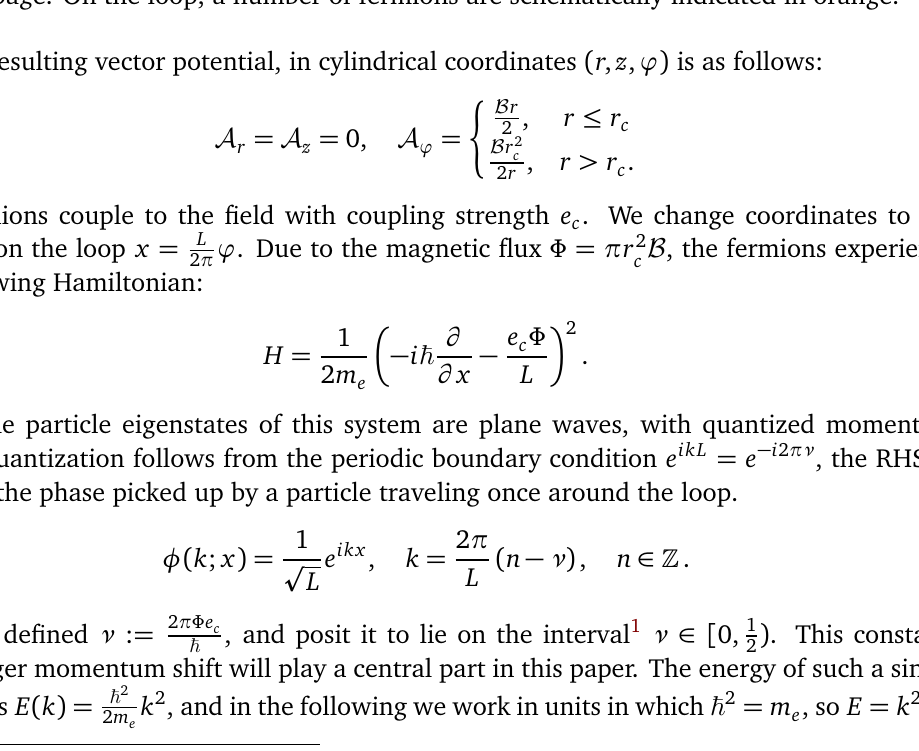
Figure 1: Setup for the Aharonov-Bohm effect. A cylindrical region in the center has a constant magnetic field going into the page. Its circular intersection is shaded B red. Strictly outside it, our loop of circumference L lies in in the horizontal plane, in the page. On the loop, a number of fermions are schematically indicated in